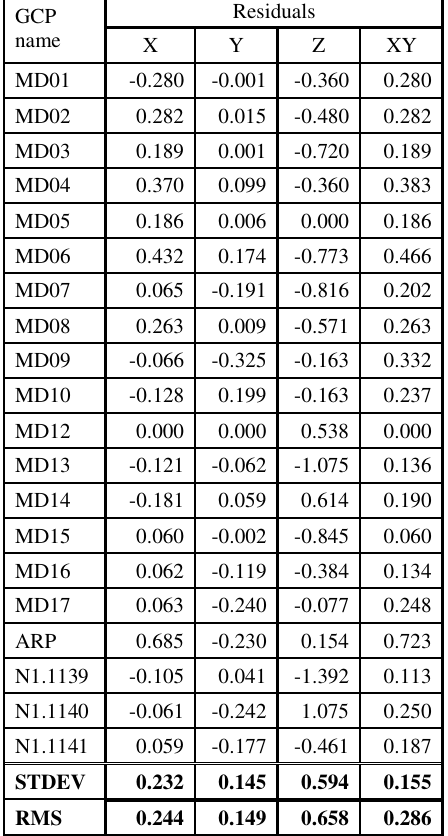
Table 3. Residuals of check points • Aerial triangulation measurements and block adjustments with three different control point configurations (one height control in the block centre, one full control in the centre, 4 GCPs at the corners